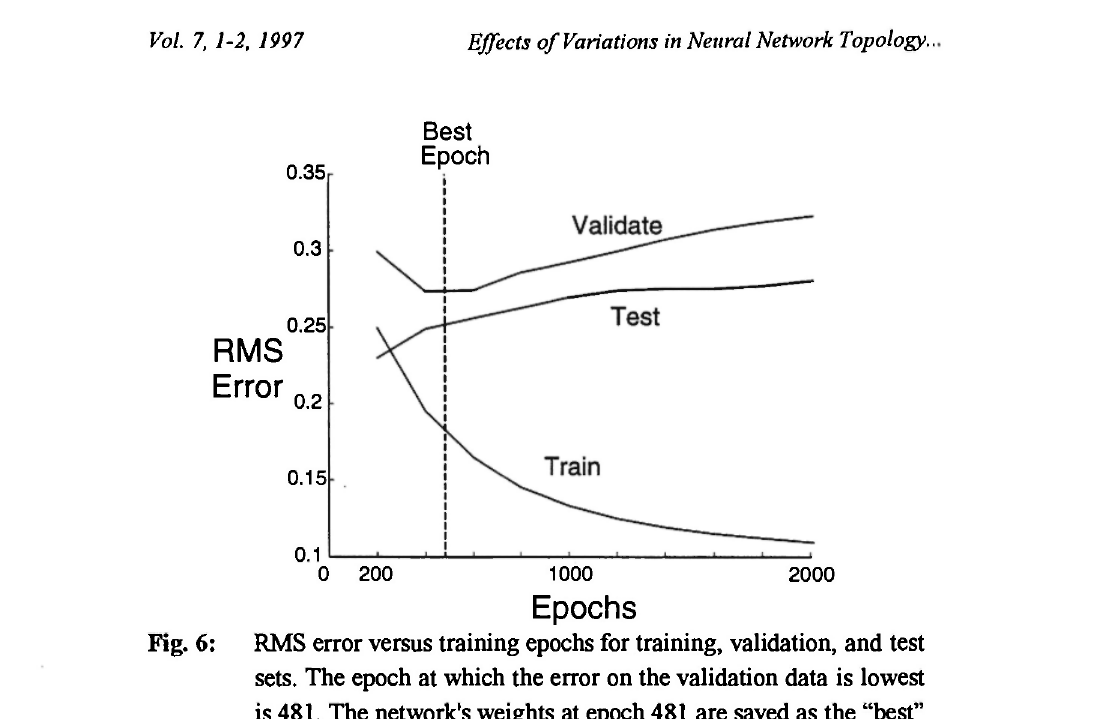
Fig. 6: RMS error versus training epochs for training, validation, and test sets. The epoch at which the error on the validation data is lowest is 481. The network's weights at epoch 481 are saved as the "best" weights. The error on the test set using these best weights is designated as the generalization error of the